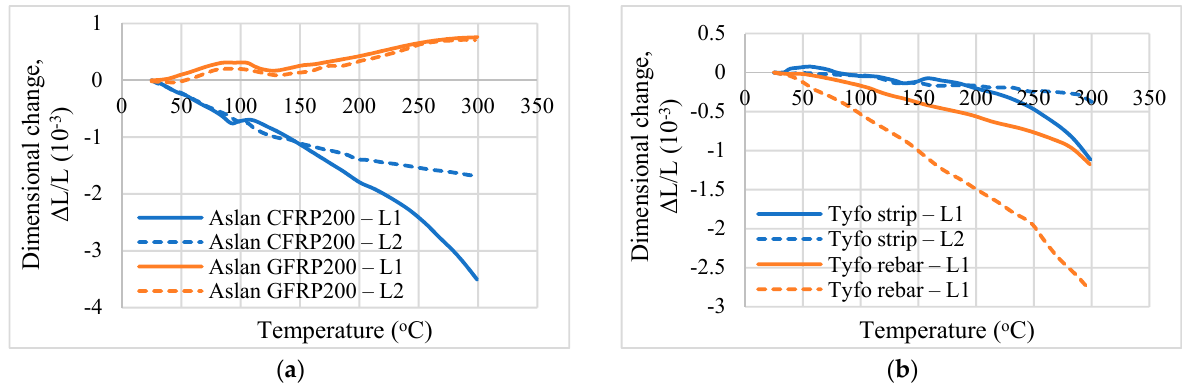
Figure 9. Thermal expansion of NSM FRP specimens in the longitudinal direction. ( a ) Thermal expansion of Aslan GFRP and Aslan CFRP. ( b ) Thermal expansion of Tyfo rods and Tyfo strips. From the measured dimensional changes, the coefficient of thermal expansion at different temperatures is computed using Equation (1) and is tabulated in Table 5. It is seen that the coefficient of thermal expansion varies significantly with the composition of the NSM FRP and direction. These measured thermal expansion results are in the same trend as that of the other conventional FRP composites used in aerospace applications. Based on the reported test data, it is recommended to evaluate the coefficient of thermal